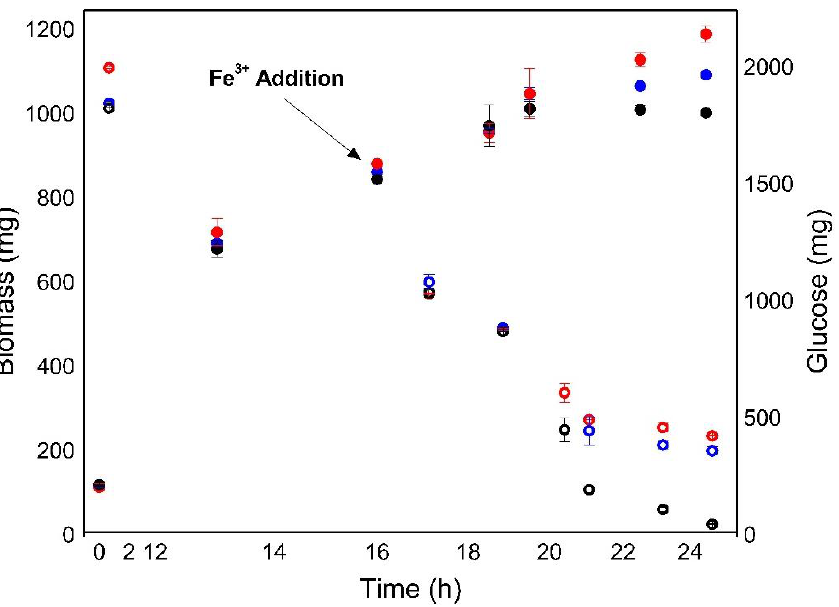
Figure 2. Effect of iron on C. sorokiniana growth in heterotrophic batch culture (medium TAP) with glucose as carbon source. Solid symbols (biomass), open symbols (glucose). Black: zero addition of Fe 3+ , Blue: 12 mg L − 1 Fe 3+ , and Red: 60 mg L − 1 . Error bars represent standard error ( n = 2).